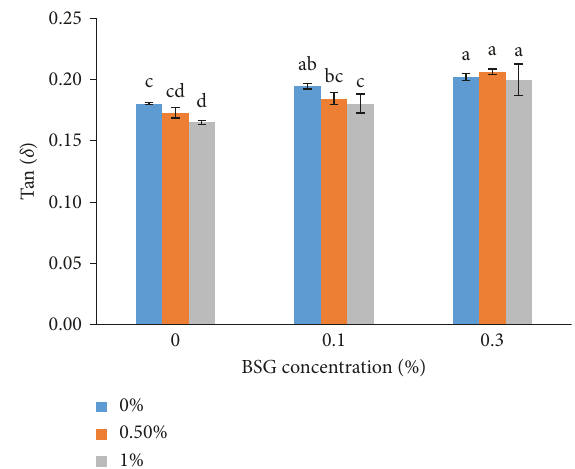
Figure 4: Effect of NaCl and basil seed gum concentration on tan ( δ ) in constant frequency of 1Hz in the foams made of egg albumin. Columns with different letters are significantly ( p